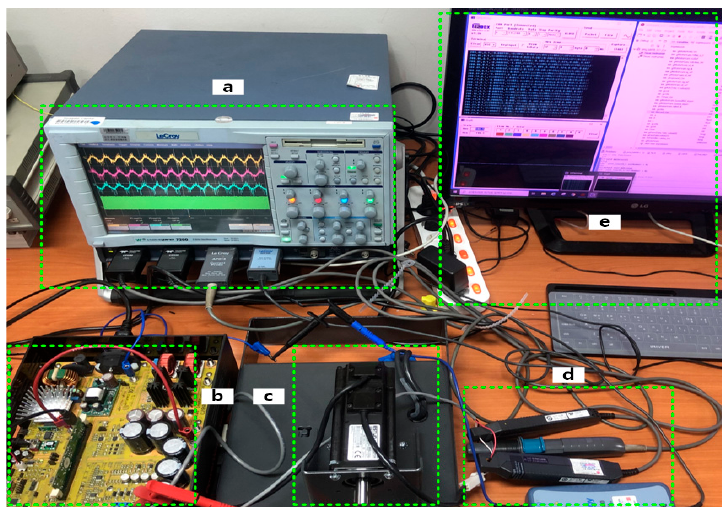
Figure 9. The experimental environment: ( a ) 4-channel oscilloscope; ( b ) control board and inverter; ( c ) SPMSM; ( d ) current and voltage probes; ( e ) personal computer.